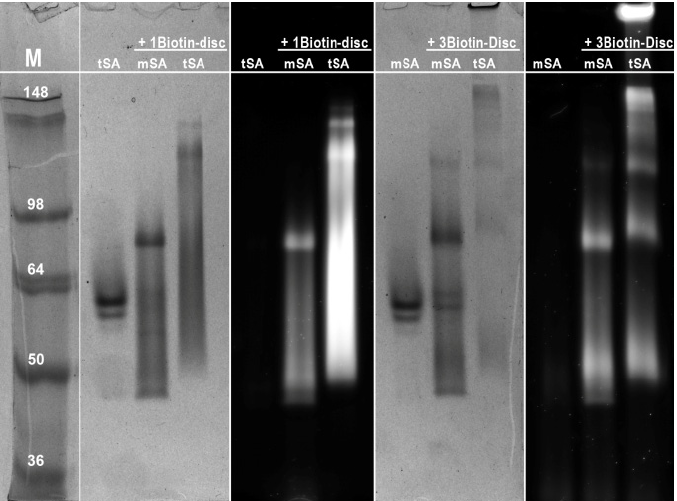
Figure 5. Semi-native SDS-gel (8%) of 1Biotin-Disc and 3Biotin-Disc (both 100 µM) with mSA (5 µM) and tSA (5 µM) stained with Coomassie blue and under UV-illumination before